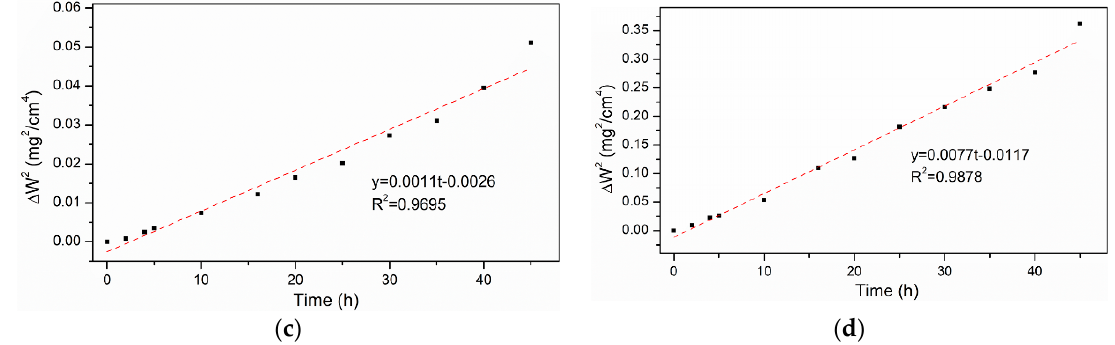
Figure 7. Isothermal oxidation results of AlCoCrFeNiTi 0.5 HEA and Ti6Al4V at 700 °C and 800 °C for 45 h; ( a ) weight gain versus oxidation time curves, the parabolic plot for ( b )Ti6Al4V at 700 °C, ( c ) HEA at 700 °C and ( d ) HEA at 800 °C.